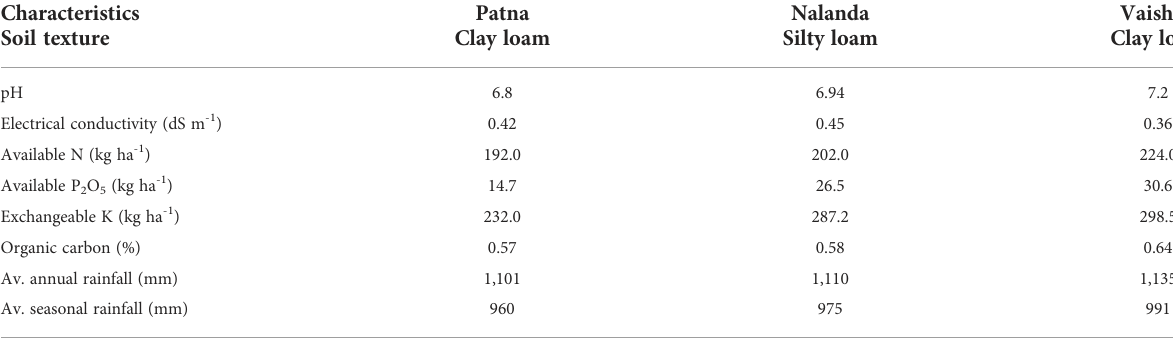
TABLE 1 Average rainfall and soil properties of study sites (2016 –